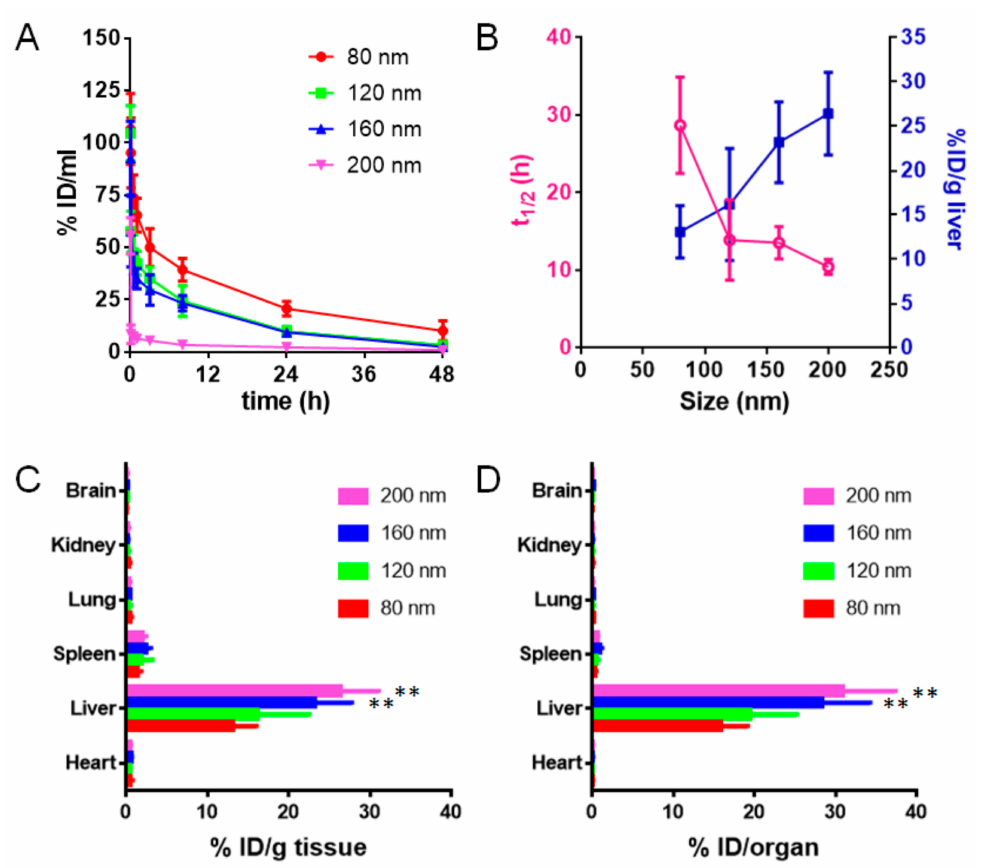
Figure 5. In vivo pharmacokinetics and tissue distribution of RBC-NPs. ( A ) In vivo pharmacokinetic curve of four di ff erent-sized RBC-NPs. ( B ) The correlation between t 1 / 2 (h) and size (nm) of RBC-NPs or the correlation between liver distribution (% ID / g liver) and size (nm) of RBC-NPs. ( C ) Tissue distribution (% ID / g tissue) of four di ff erent-sized RBC-NPs 48 h post intravenous injection. ( D ) Tissue distribution (% ID / organ) of four di ff erent-sized RBC-NPs 48 h post intravenous injection. ** p < 0.01 compared with 80